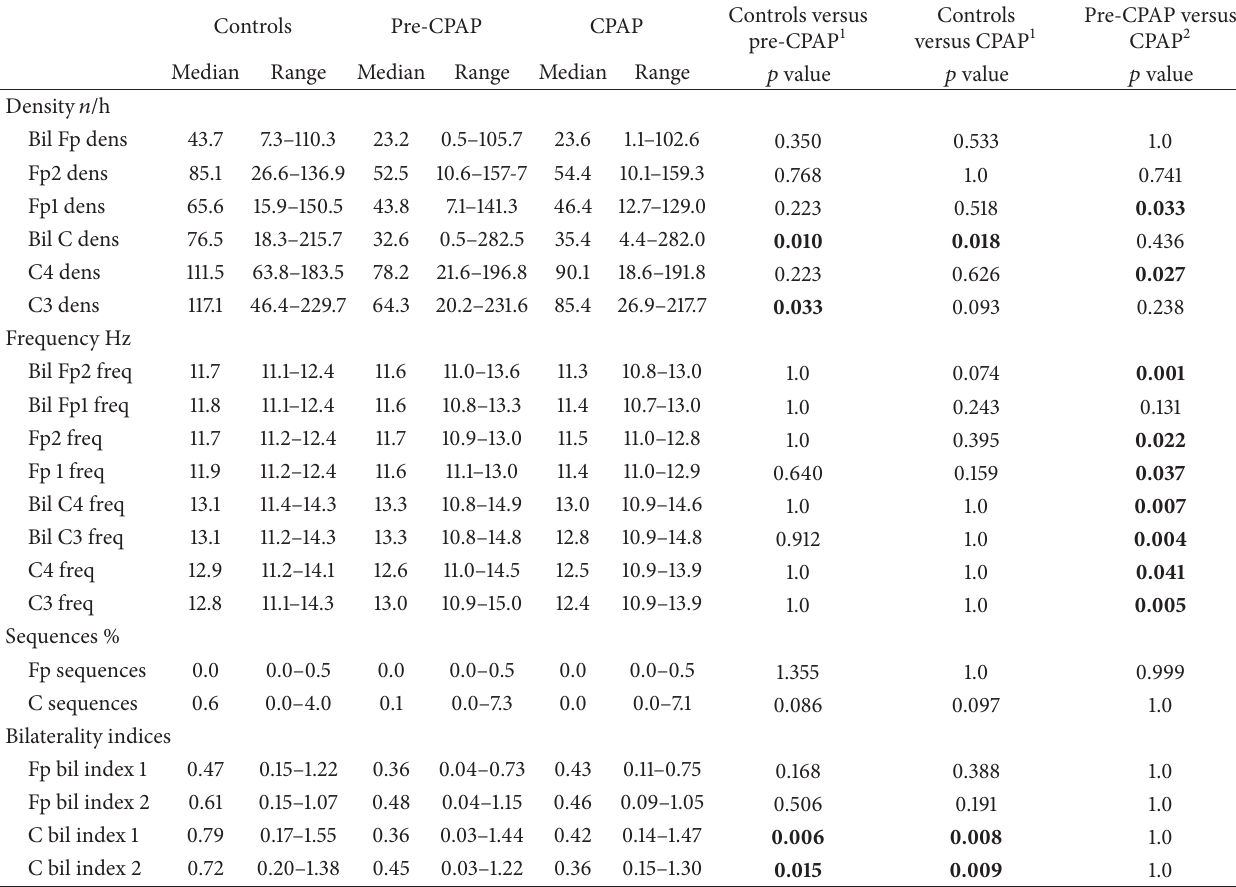
Table 5: Median and range of the spindle features in the study groups at the last part of the NREM